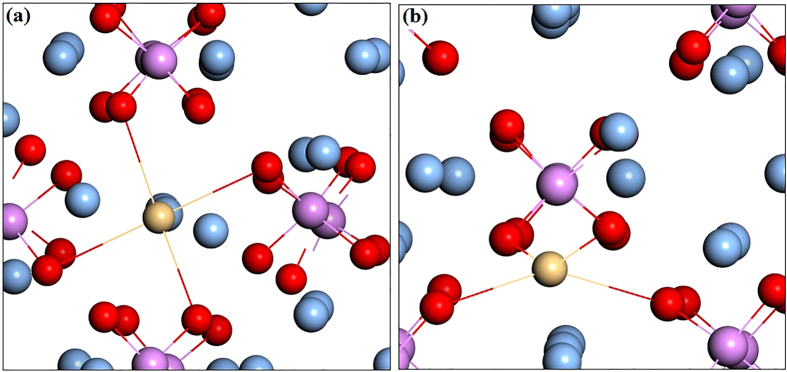
Atomic geometry of the relaxed structures of the (a) Cdi and (b) Cdi(s) configurations in Ag3PO4.